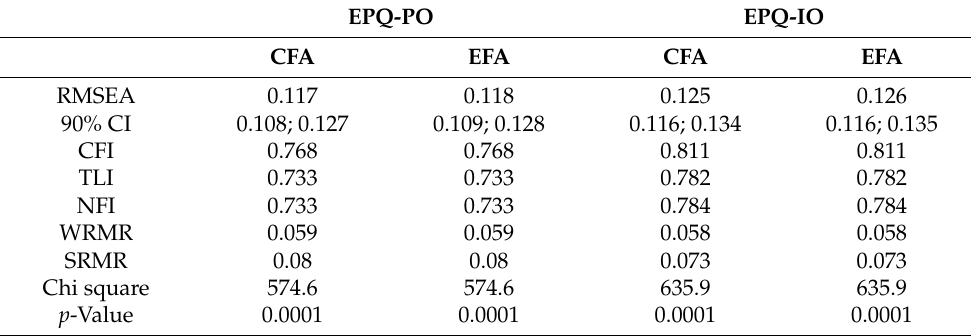
Table 3. CFA and EFA fit statistics.